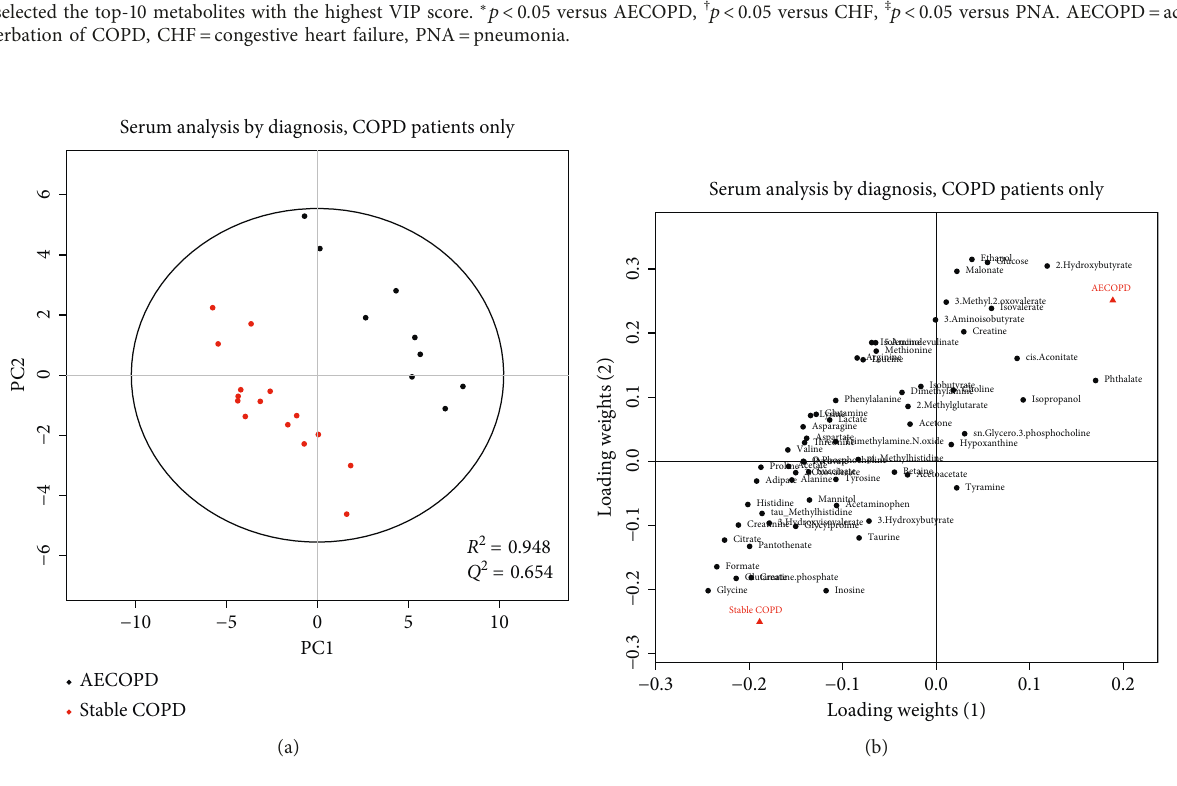
Figure 3: PLS-DA score plots (a) and loading plots (b) of serum samples drawn from patients with stable COPD (red) or AECOPD (black). Each circle represents a serum sample. The two groups are well separated in the score plots. The loading plot shows how the profiled metabolites contribute to the separation seen in the scores. The model is not statistically significant ( p (cid:136) 0 . 997), but the fit is quite good ( R 2 (cid:136) 0.948), as is the predictive value ( Q 2 (cid:136) 0.654). This indicates that the model is overfit and suffers from a low sample size.